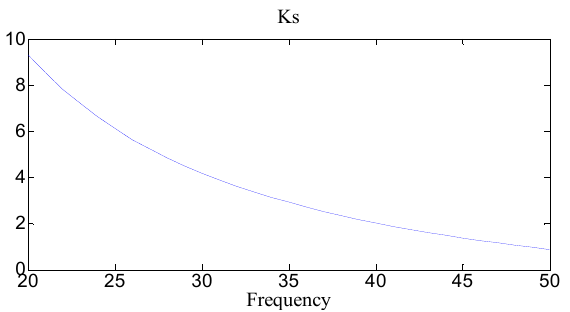
Figure 5. Variations of K s versus frequency.